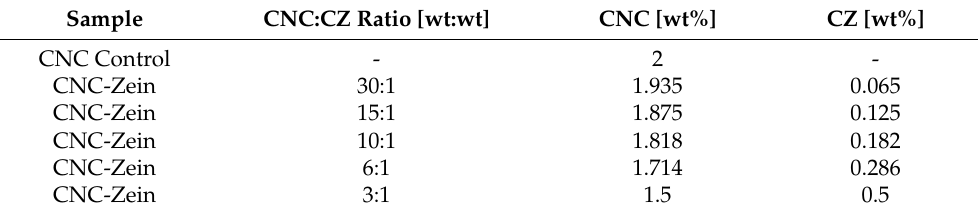
Table 1. Compositions of CNC and CZ biocomposite